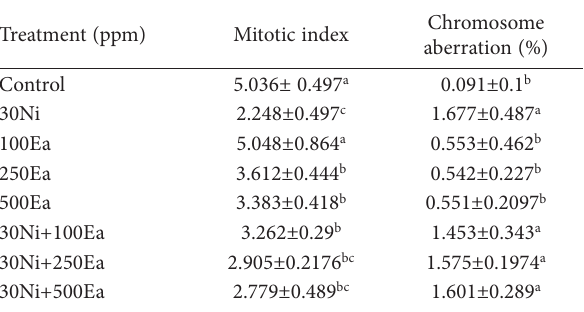
Table 1. The Mitotic index and percentage of chromosomal aber- ration of A. cepa root tip cells induced by Ni, encapsulated E. acoroides leaves extract and mixture of Ni and encapsulated extract.